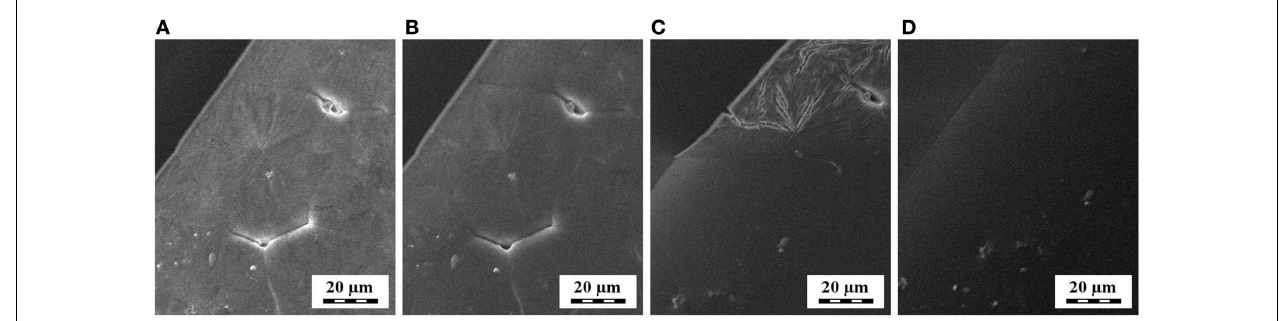
FIGURE 11 | Melting of spherulites at the surface of thin POM film, as observed by in situ SEM microscopy during heating: (A) 150°C, (B) 155°C, (C) 160°C, and (D) 165°C